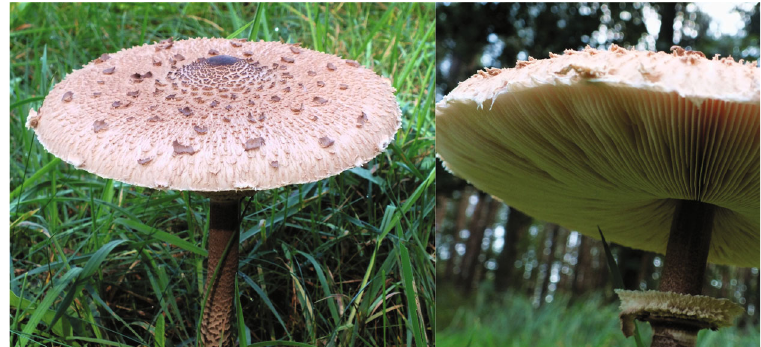
Figure 1: The fruiting bodies of the fungus Macrolepiota procera . The appearance of the mushroom from above and